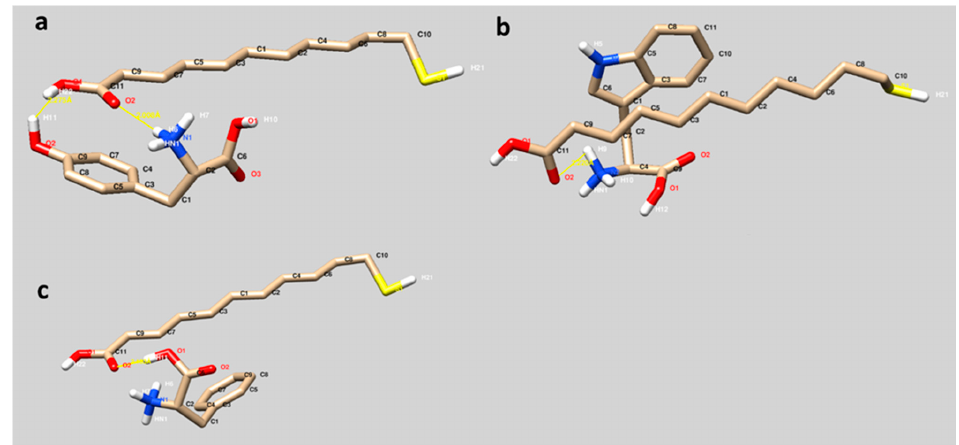
Figure 2. Molecular modeling of 11-MUA to three different amino acids Tyr ( a ), Trp ( b ) and Phe ( c